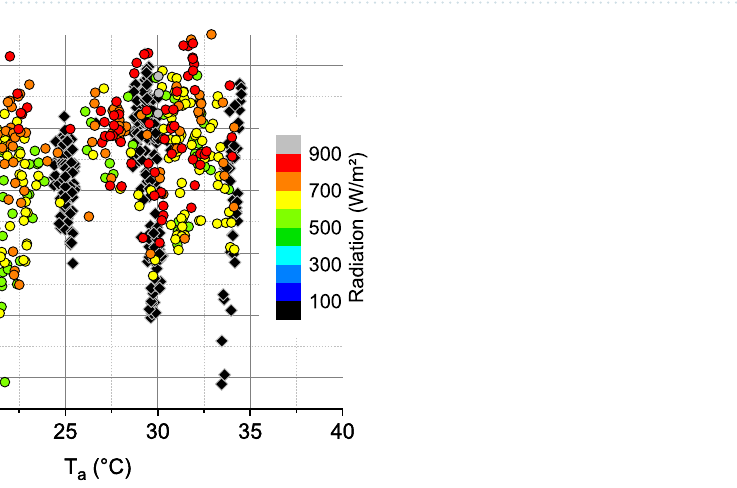
Figure 1. Body temperature and heat exchange of foraging honeybees. ( a ) Infrared thermogram of honeybees ( Apis mellifera carnica ) foraging sucrose solution. Note heated thoraxes resulting from intense endothermy with activated flight muscles. Part of the heat has warmed the head and the abdomen. Ambient air temperature (T a ) = 13 °C. ( b ) Main paths of heat flow, inside the body and in and out of it. Circles symbolize spiracles (6 on thorax, and 12 on abdomen; 56,57 ). M = metabolism, mainly of flight muscles plus standard metabolism of other tissues.